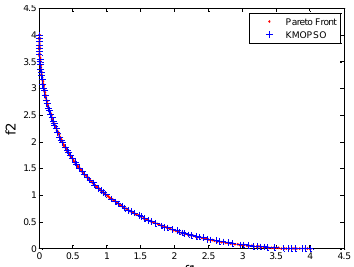
Fig. 3. Pareto fronts produced by KMOPSO for SCH.